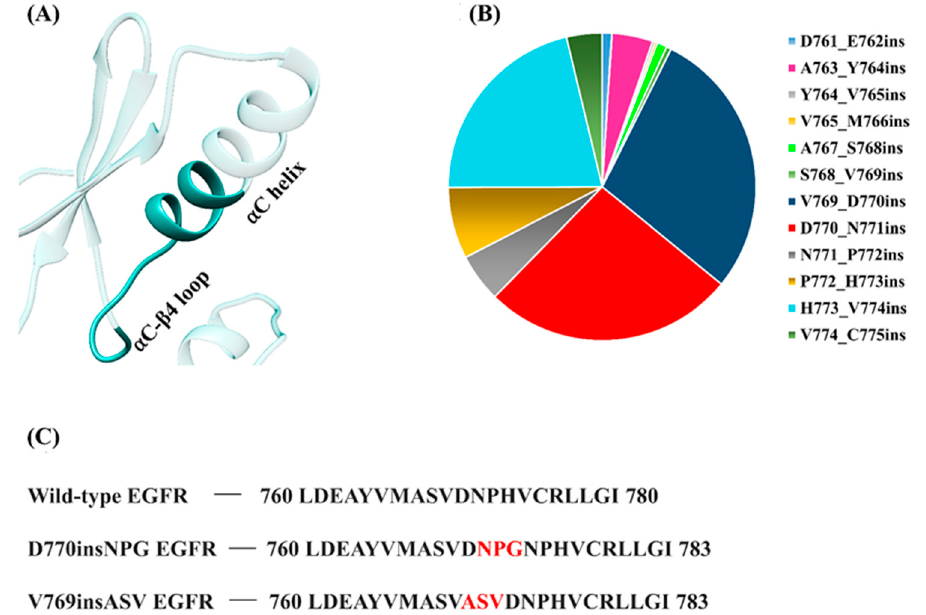
Figure 2. EGFR exon 20 insertion mutations. ( A ) Location of exon 20 insertion mutations (solid cyan color) within the C-terminal half of the α C helix and the α C- β 4 loop of the EGFR kinase domain. ( B ) Relative frequencies of EGFR exon 20 insertion mutations observed in non-small cell lung cancer (NSCLC) as retrieved from the COSMIC database (v92) [33]. ( B , C ) The most commonly observed EGFR exon 20 insertion mutations in NSCLC include V769_D770ins (28.5%) and D770_N771ins (26.4%); ( C ) the insertion sequences for D770insNPG and V769insASV are highlighted in red.